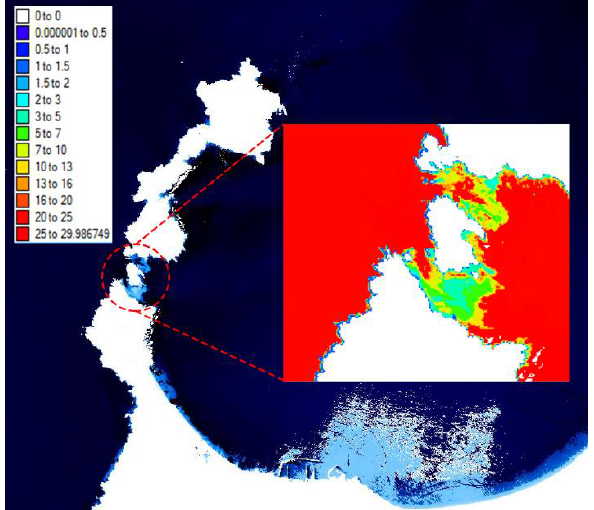
Figure 10. Adjusting the maximum “deep water” values with the sliders interface.